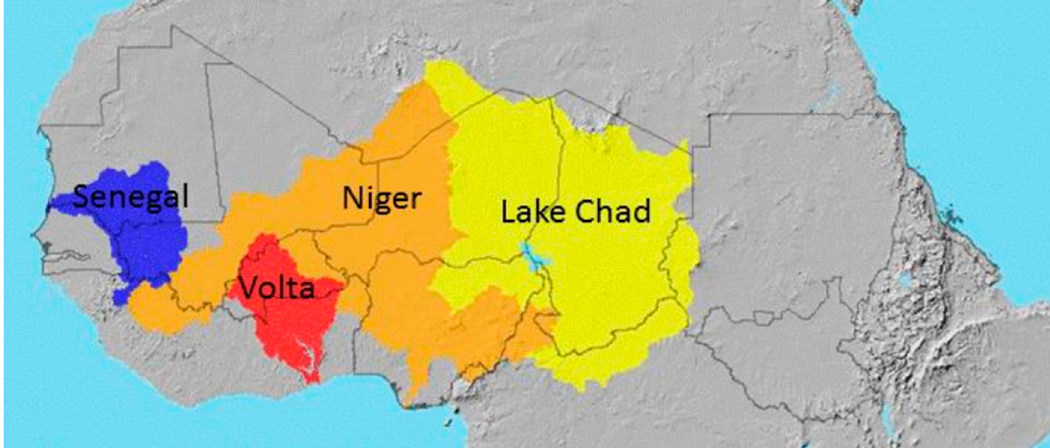
Figure 1. Niger, Lake Chad, Volta, and Senegal basins. Source: [19] Van Der Wijngaart et al., 2019. The Senegal River basin cuts across four countries: Guinea, Mali, Mauritania, and Senegal.